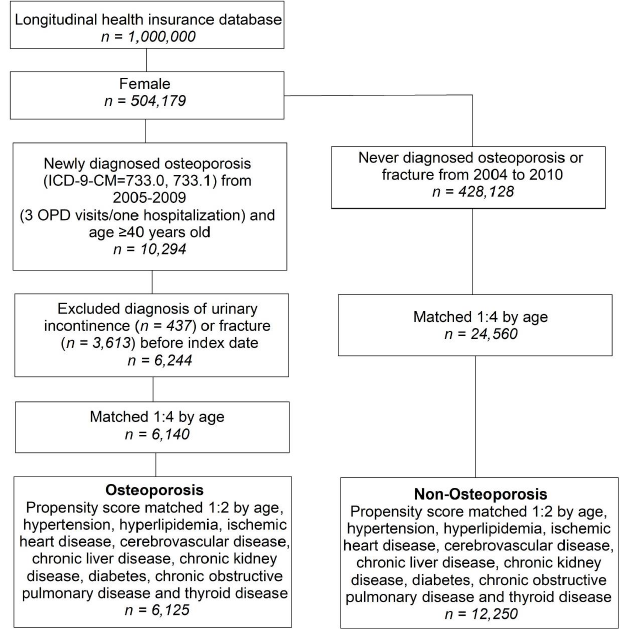
Figure 1. Participant selection process for the OS and Non-OS groups. OS, osteoporosis; OPD, Outpatient Department.